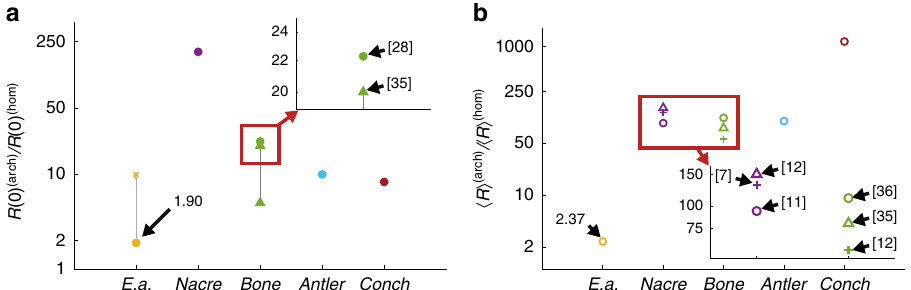
Fig. 8 Comparison of toughness enhancements in the Ea . spicules and other SBMs with layered architectures. a The initiation toughness enhancement metric R (0) (arch) ∕ R (0) (hom) of the Ea . spicules and other SBMs with layered architectures. We used the value R (0) (hom) = 3 Jm − 2 of calcite as the control material for nacre and conch 68 , and R (0) (hom) = 10 Jm − 2 of hydroxyapatite 68 as the control material for bone and antler. For Ea ., the solid circle represents the average and the cross represents the approximate value of the maximum enhancement which we observed for very short notches. b The average toughness enhancement metric 〈 R 〉 (arch) ∕ 〈 R 〉 (hom) of the Ea . spicules and other SBMs with layered architectures. We used the value 〈 R 〉 (hom) = 22 Jm − 2 of limestone as the control material for nacre and conch 69 , and 〈 R 〉 (hom) = 140 Jm − 2 of hydroxyapatite 70 as the control material for bone and antler. In both a and b , the values of R (0) and 〈 R 〉 for nacre, bone, antler, and conch ( S. gigas ) were obtained from the literature (see Supplementary Table 1). The multiple values for bone in a and for nacre and bone in b correspond to experiments performed by different research groups. The two green triangles connected by a line in a correspond to the range of values reported by 35 . The references from which the data points were obtained are annotated in the insets. Note that in both a and b the toughness enhancement metrics are plotted using a logarithmic